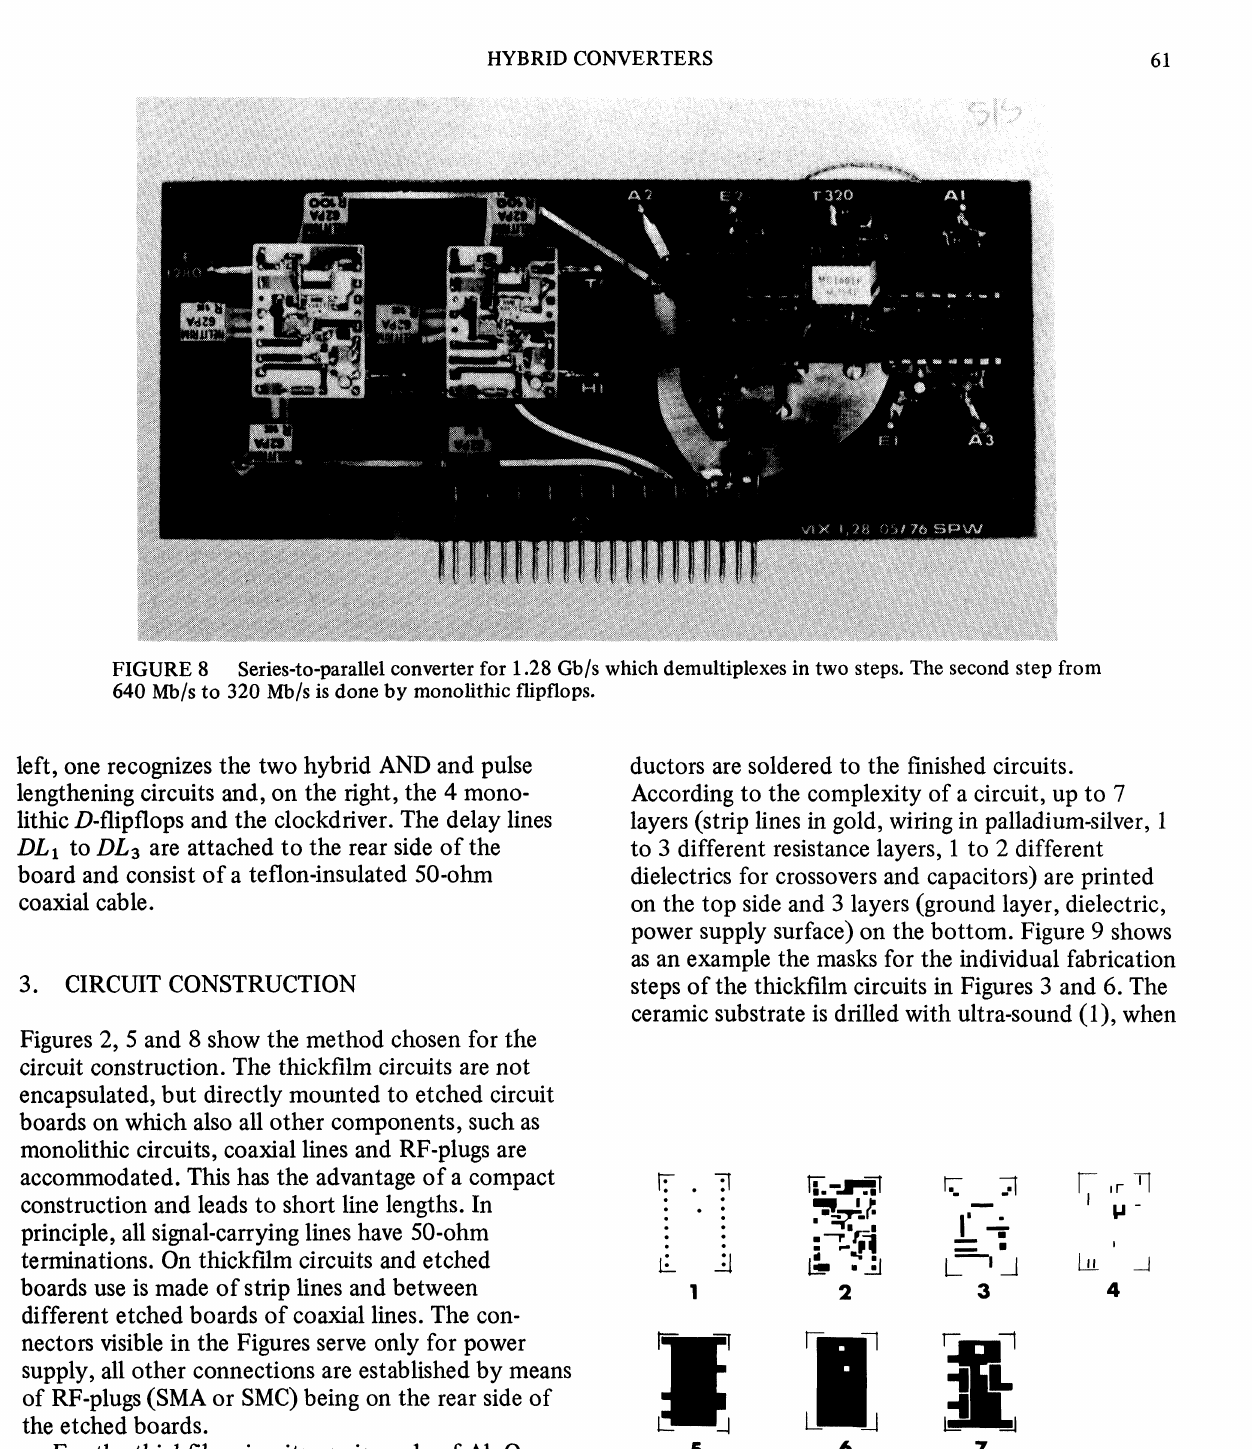
Thickfilm masks for the circuits of Figures 5 and 8. Masks to 4 are for the front side, masks 5 to 7 for the rear